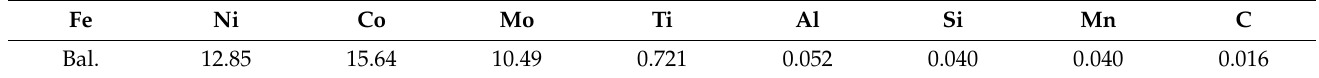
Table 1. Chemical Composition of the maraging steels